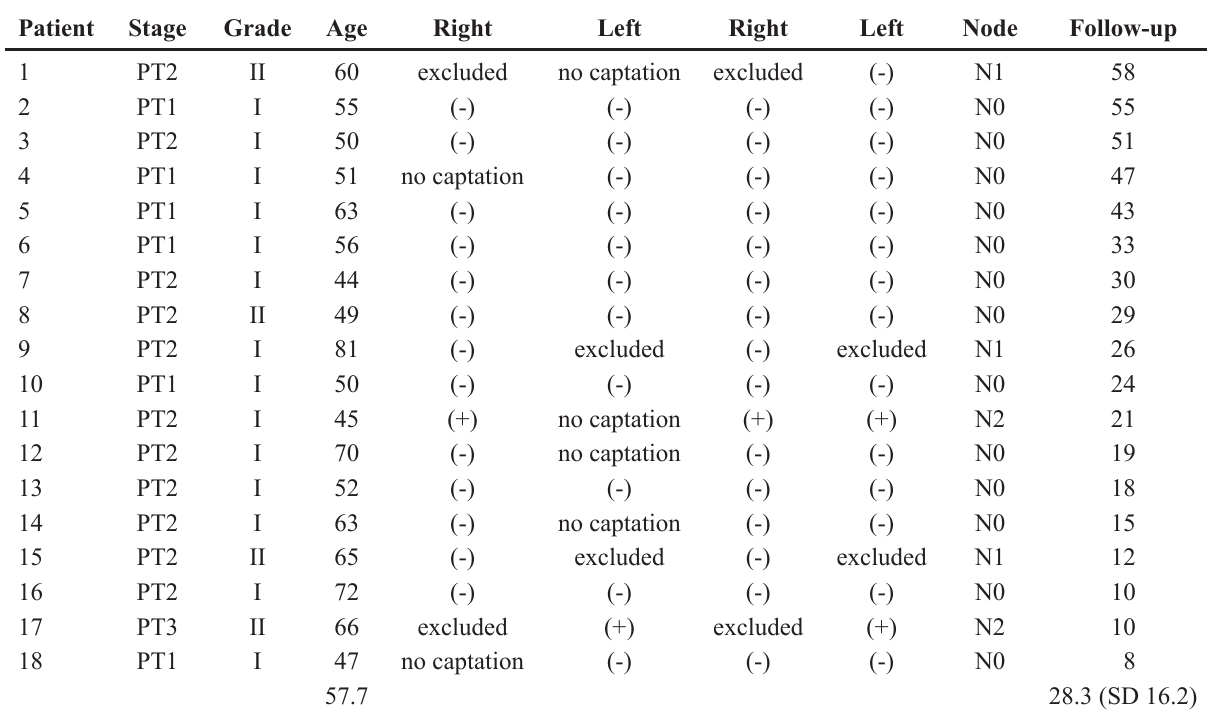
Table 1 – Cases studied and results